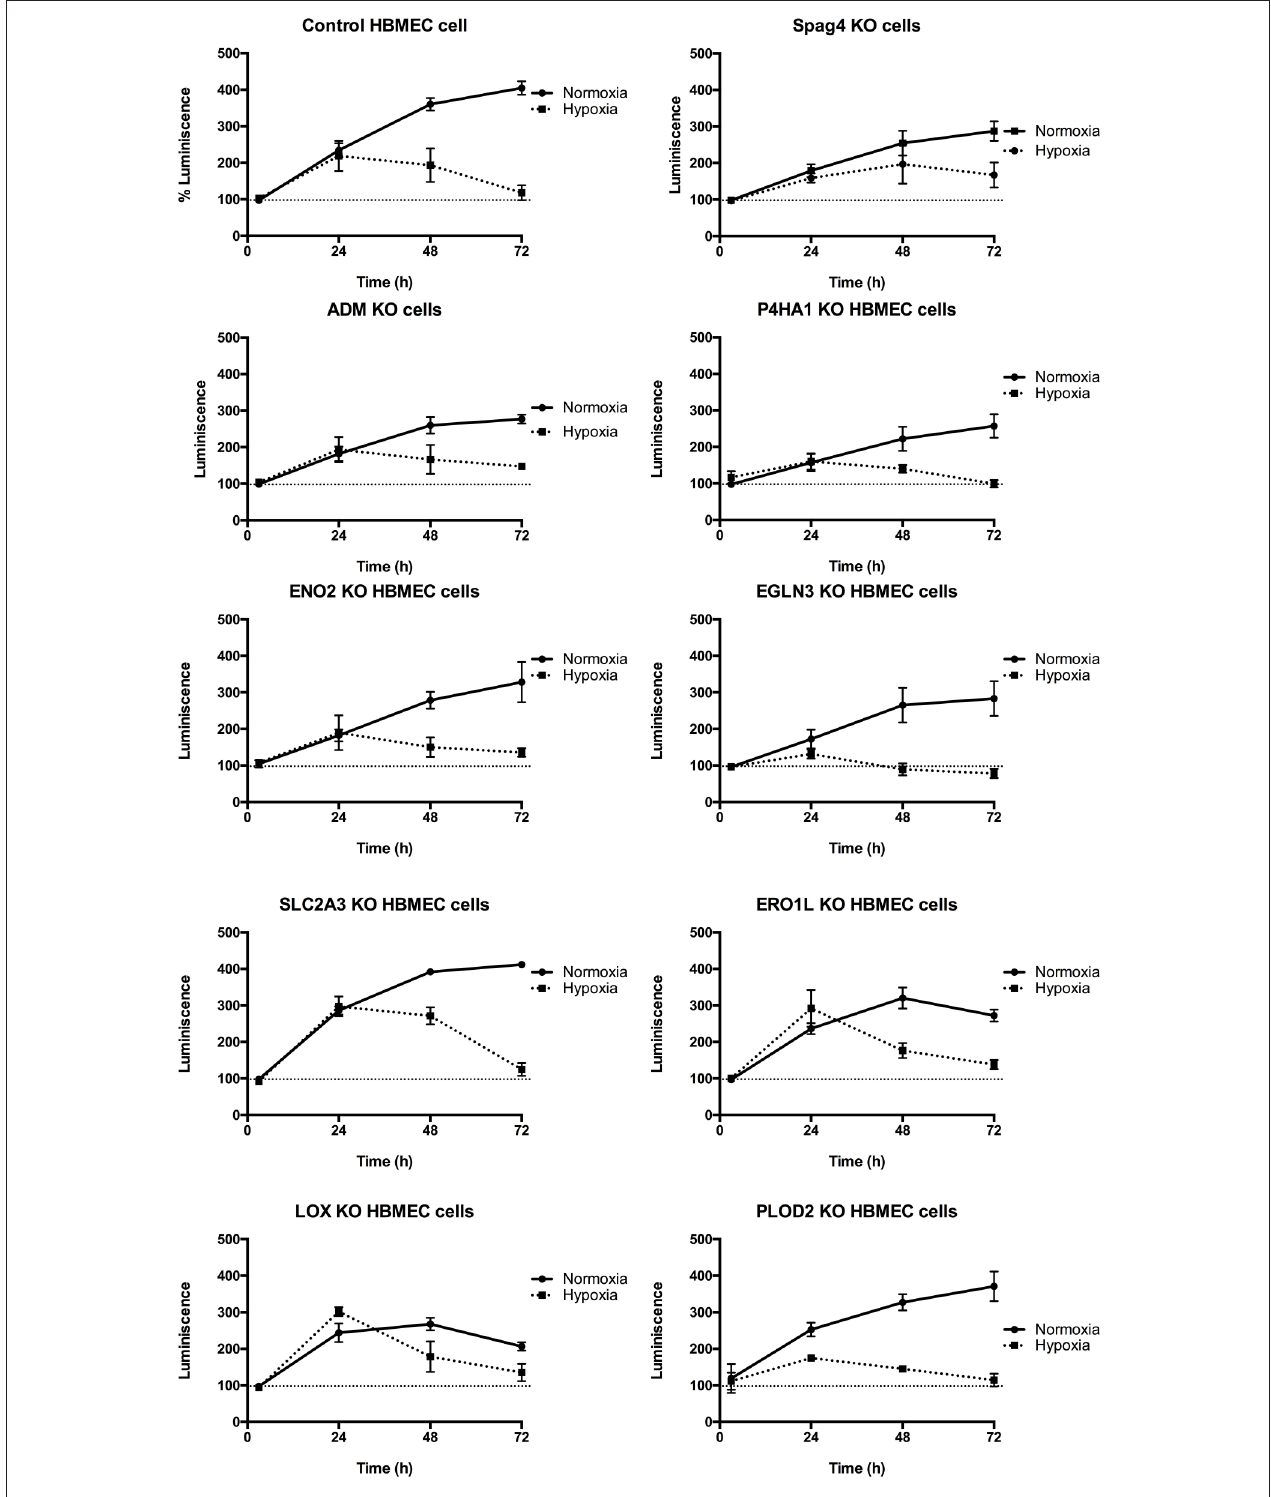
FIGURE 3 | Demonstrates the effect of 0.5% oxygen (hypoxic) and 21% oxygen (normoxic) for 3 days on normal cells and the cells with mutated genes by Crispr/Cas9. N = 6 in each group.